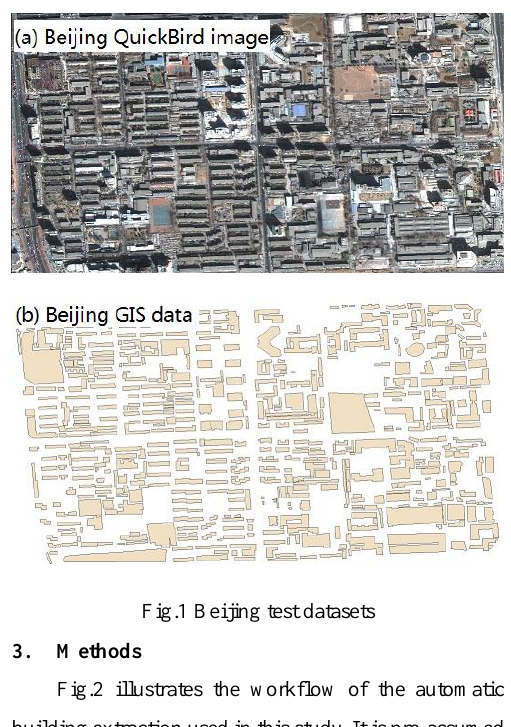
Fig.1 Beijing test datasets